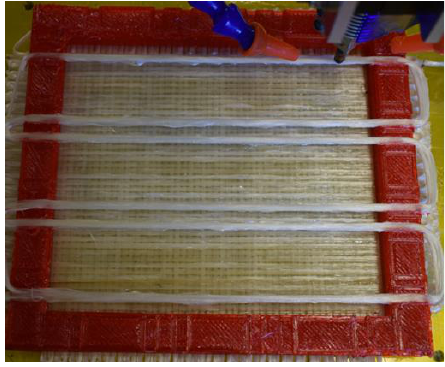
Figure 8. Composite Scaffolding in ‘ 1 ’ Direction.